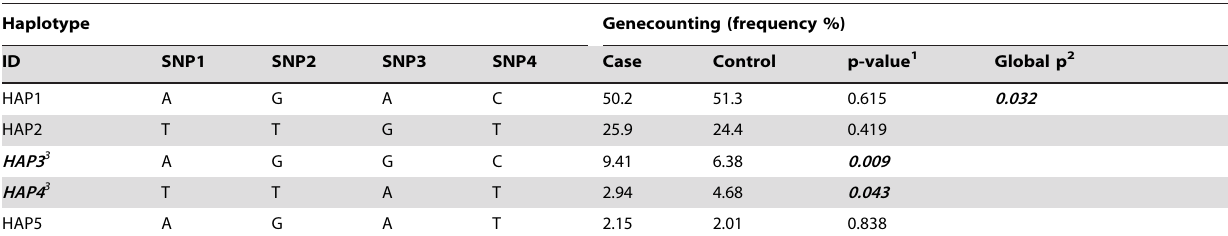
Table 5. Haplotypes frequency and association